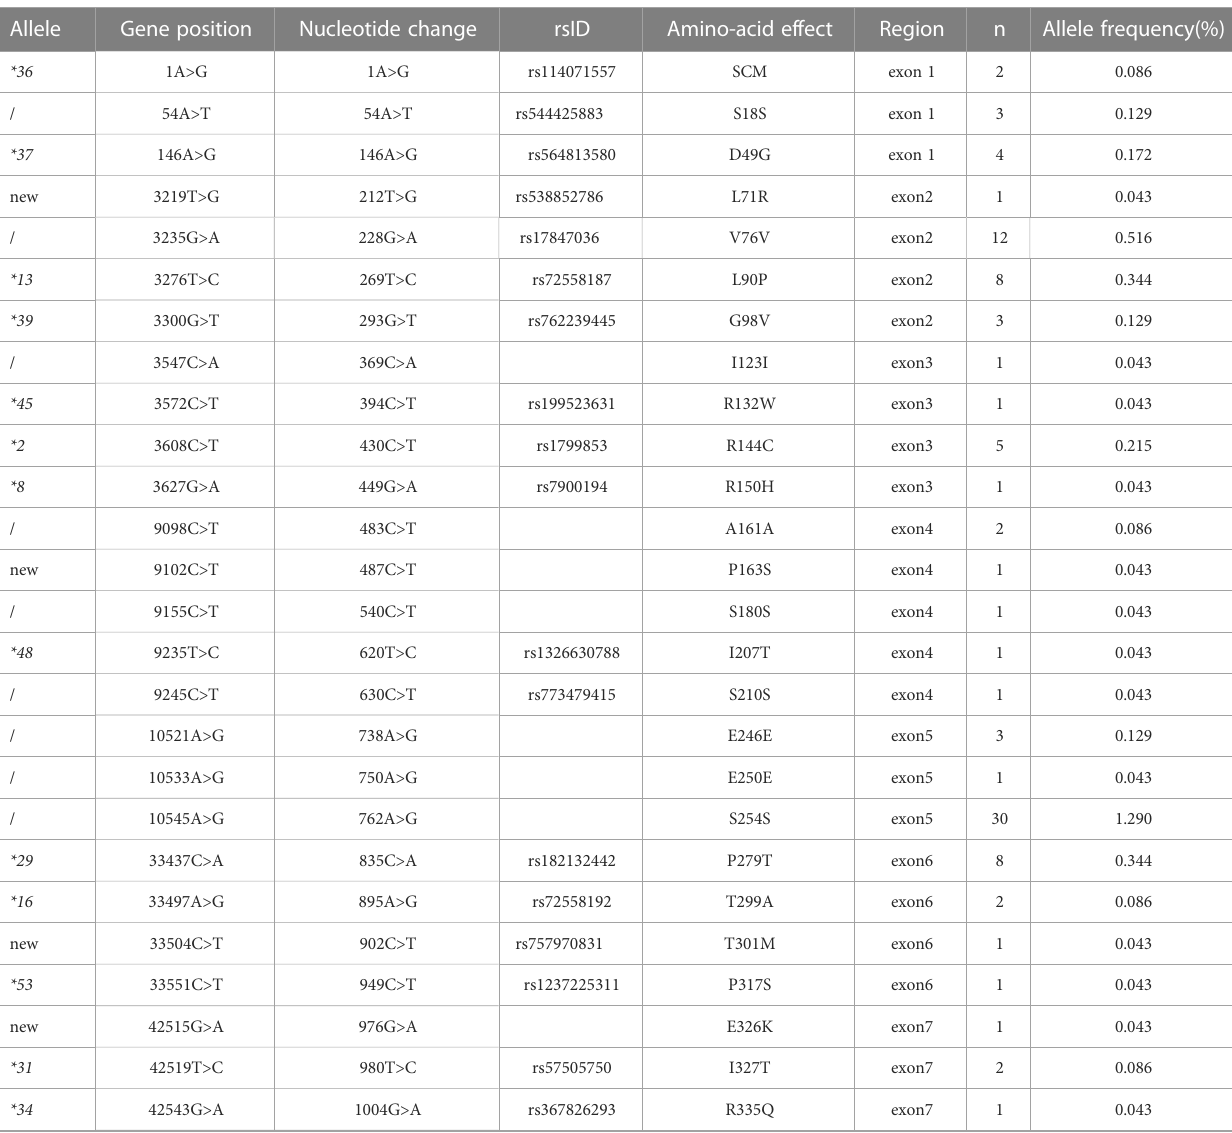
TABLE 3 Allelic CYP2C9 variants identi fi ed in 1163 Chinese Han